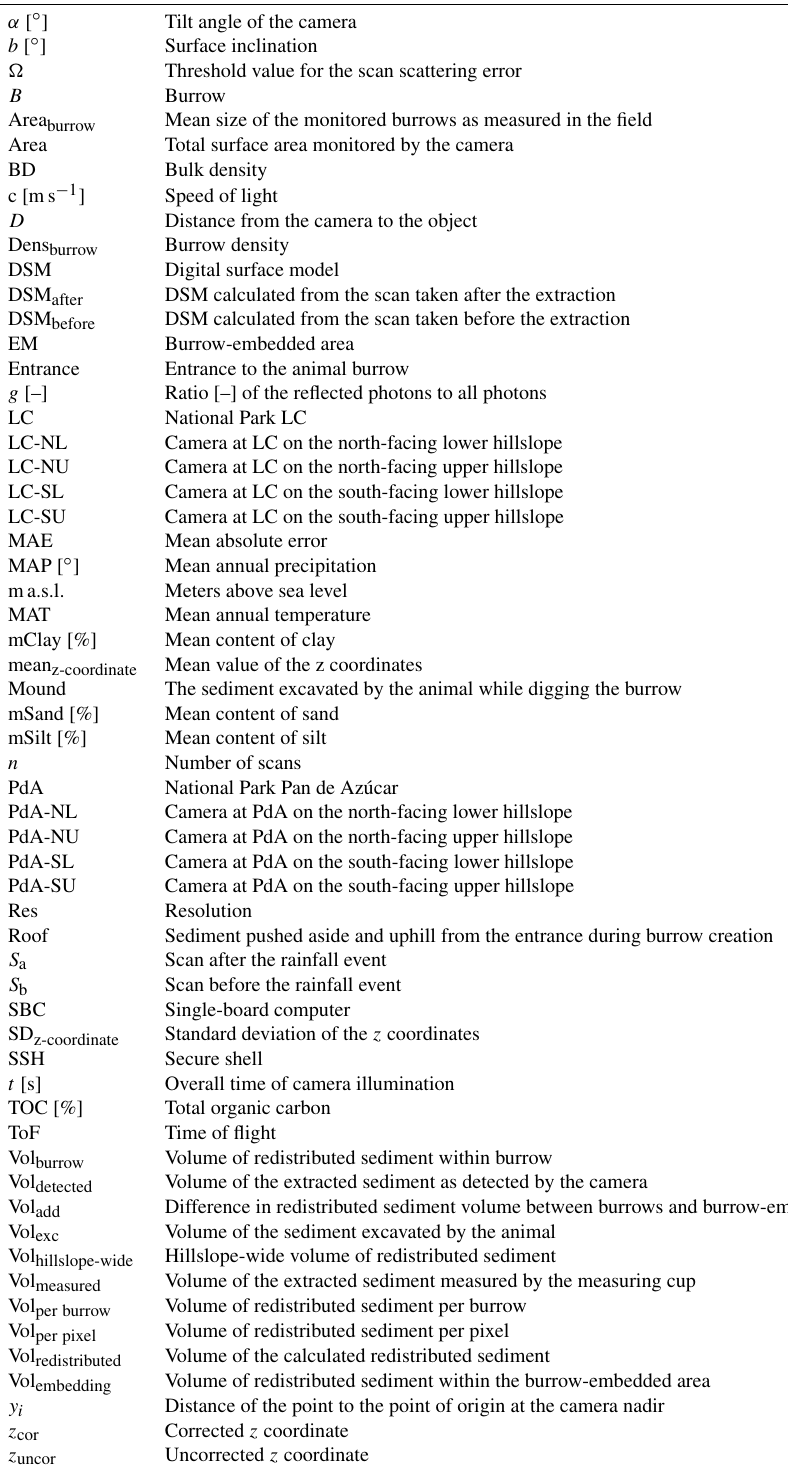
Table A1. List of